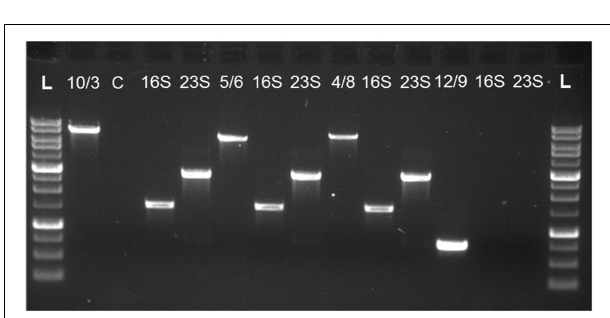
FIGURE 6 | Confirmation of the presence of rDNA operons located within contig gaps. PCR products joining the ends of two contigs were used as templates for PCR to determine presence of rRNA genes within the gaps. Gaps that tested positive for rRNA operons were closed using our innovative rRNA gap sequencing procedure as illustrated in Figure 4 . Gaps that did not contain rRNA operons required traditional primer walking to determine the missing sequence. PCR products labeled as 16S and 23S rRNA genes were amplified from the respective preceding PCR product corresponding to the following gaps; 10/3 – gap between contig 10 and contig 3, 5/6 – gap between contig 5 and contig 6, 8/4 – gap between contig 8 and contig 4, 12/9 – gap between contig 12 and contig 9. L represents a 1kb molecular weight ladder and C is a representative template control utilizing distant primers not expected to be contained within the 10/3 gap to confirm template